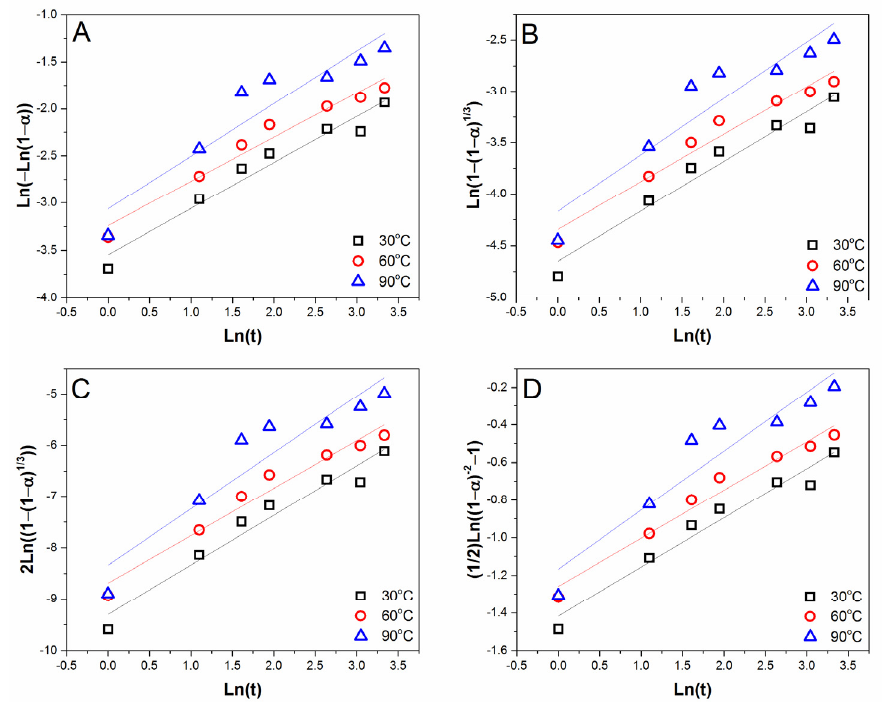
Figure 7. Graph of models fitting with ( A ) Avrami; ( B ) Geometric Contraction; ( C ) Diffusion; ( D ) Third order equation and determination of their constant reaction values.